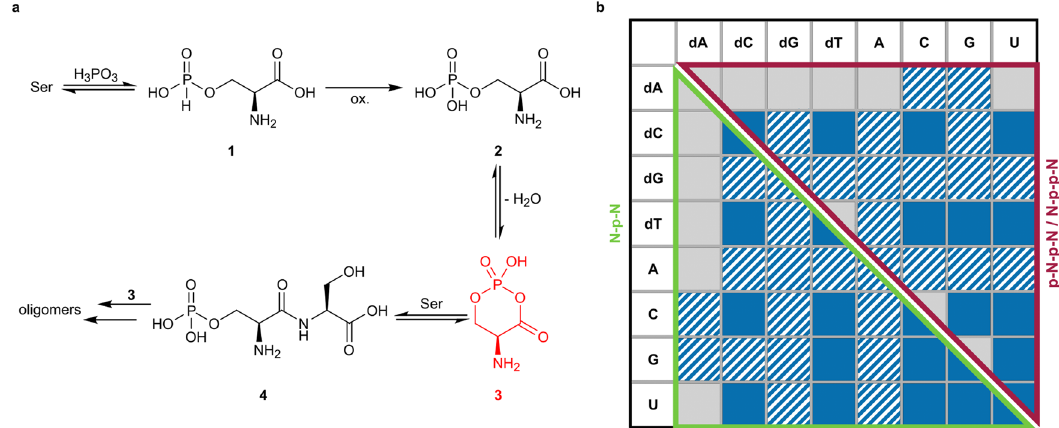
Fig. 4 Peptide formation starting from Ser and reaction of nucleoside mixture. a Proposed mechanism for phosphate mediated peptide formation starting from Ser based on the mechanism for trimetaphosphate mediated amino acid coupling suggested by Rabinowitz et al. (black: m/z value found; red: m/z value not detected; oxidation: ox.) 80 . b Products of the reaction starting from a mixture containing all canonical nucleosides (each 25 mM, in total 1.0 eq.) with H 3 PO 3 (3.0 eq.) and urea (1.0 eq.) after 7 d. The reaction mixture was analyzed by CE-MS (blue: detected, grey: not detected, hatched: several nucleoside combinations with identical m/z values are possible and consequently the signal could not be assigned unambiguously to one nucleoside